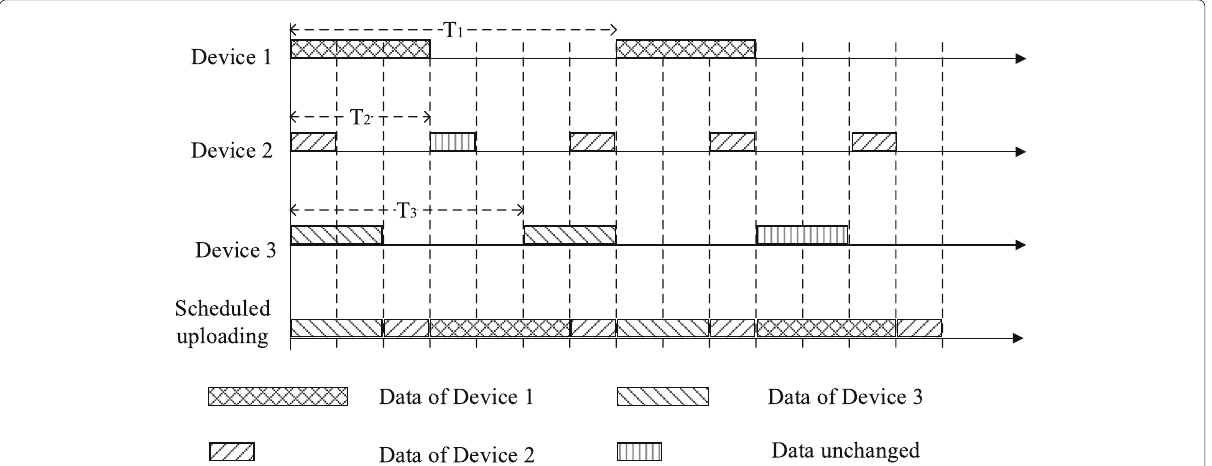
Fig. 2 Frame structure and scheduled uploading. The figure describes the data structure of devices 1, 2, and 3 and the scheduled uploading of these three devices at the